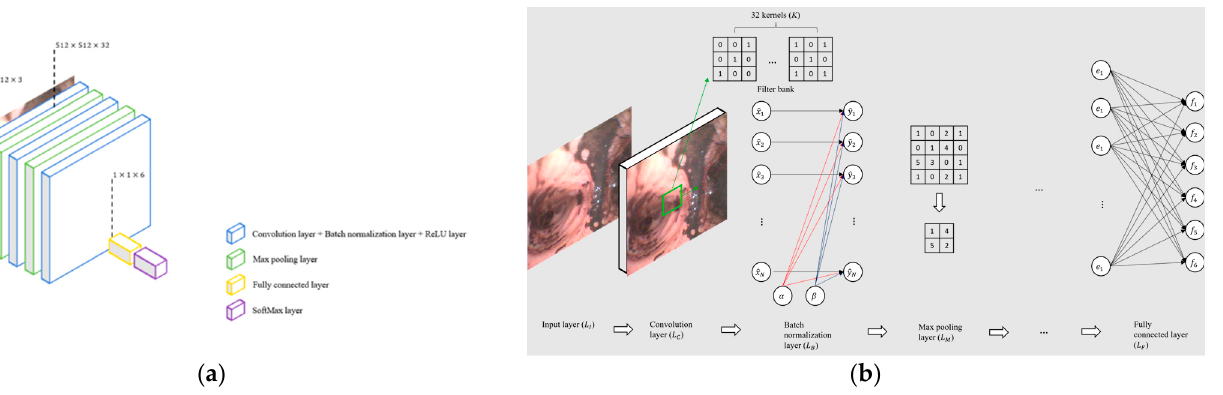
Figure 7. ( a ) Architecture of CNN-13, which is a typical 13 layers deep CNN model (includes 3 convolution layers). ( b ) The details of how hidden layers in CNN-13 work.